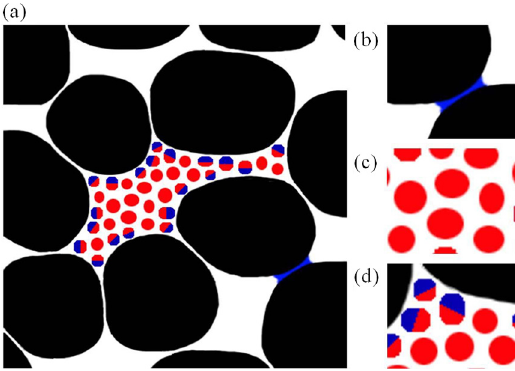
Figure 14. (a) Tight-bond cluster model; (b) The interconnecting zone between clusters; (c) Free volume zone; (d) The connecting condition between atoms in the boundary of